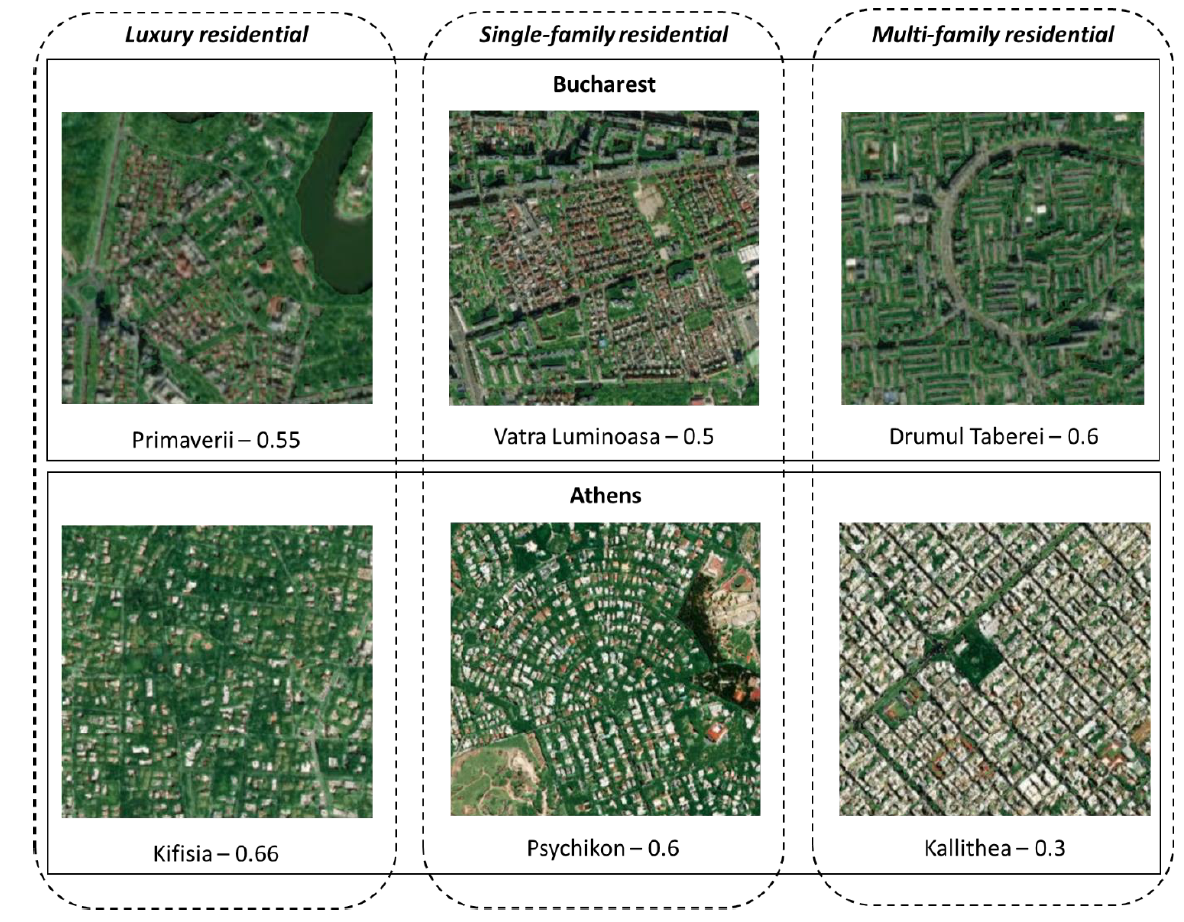
Figure 7. Sample of small green area with high NDVI values in Bucharest and Athens.